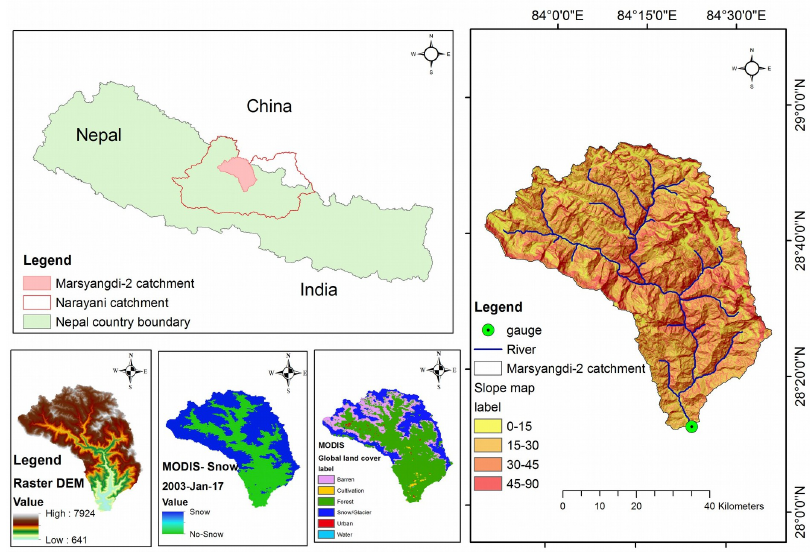
Figure 1. Location map of the Marsyangdi-2 River